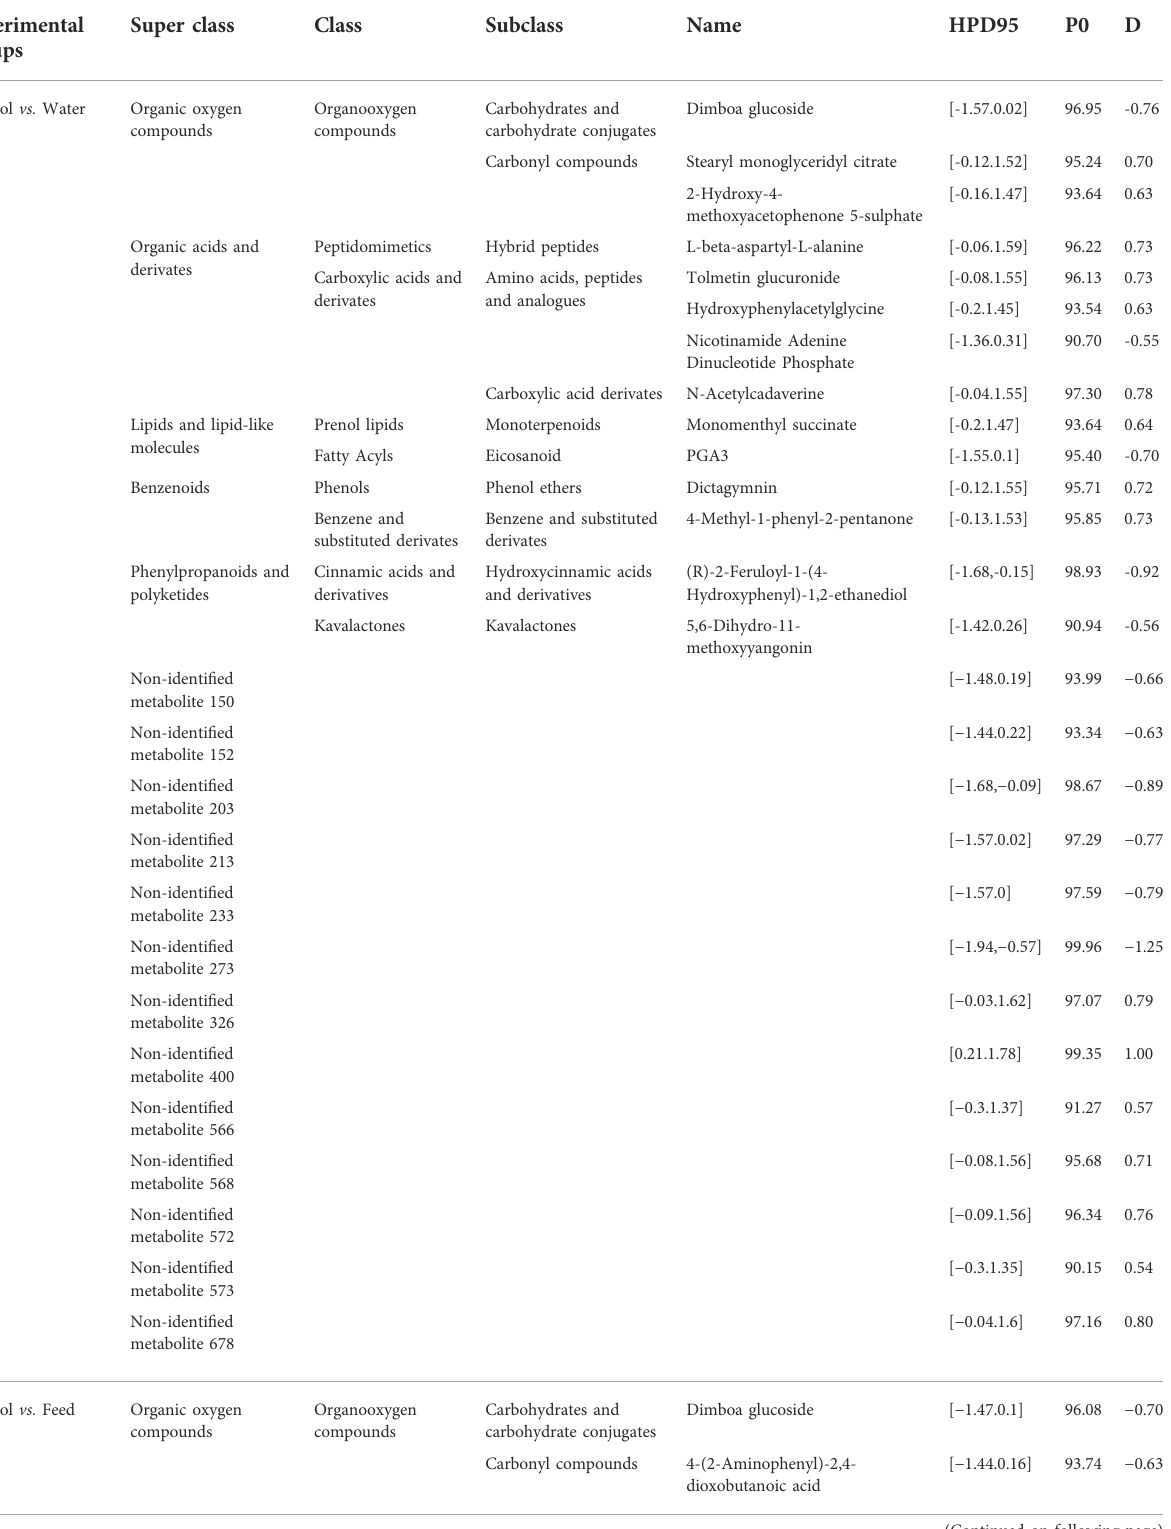
TABLE 2 Caecal metabolome features characterised for Salmonella -free broilers treated with a Salmonella phage. Key metabolites identi fi ed by partial least square-discriminant analysis (PLS-DA) for discriminating between groups with relevant differences in mean abundance based on Bayesian statistical analysis in water- and feed-phage treated chickens compared with the control group, computed as control vs. waterand control vs. feed. The water group received a 10 8 PFU/ml phage concentration via drinking water. The feed group received a 10 8 PFU/g phage concentration via feed (encapsulated). The control group did not receive a